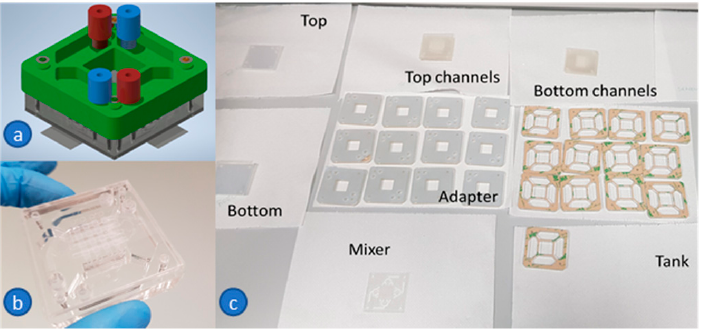
Figure A1. ( a ) Autodesk Inventor ® design of the COP device with connectors; ( b ) Final assembled device; ( c ) Laser-cut parts for a batch of devices.